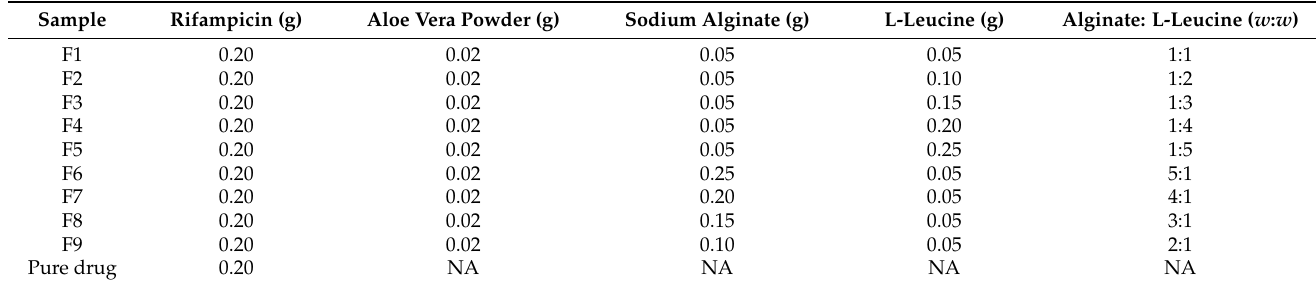
Table 1. Formulation designs of spray-dried rifampicin-loaded microparticles.